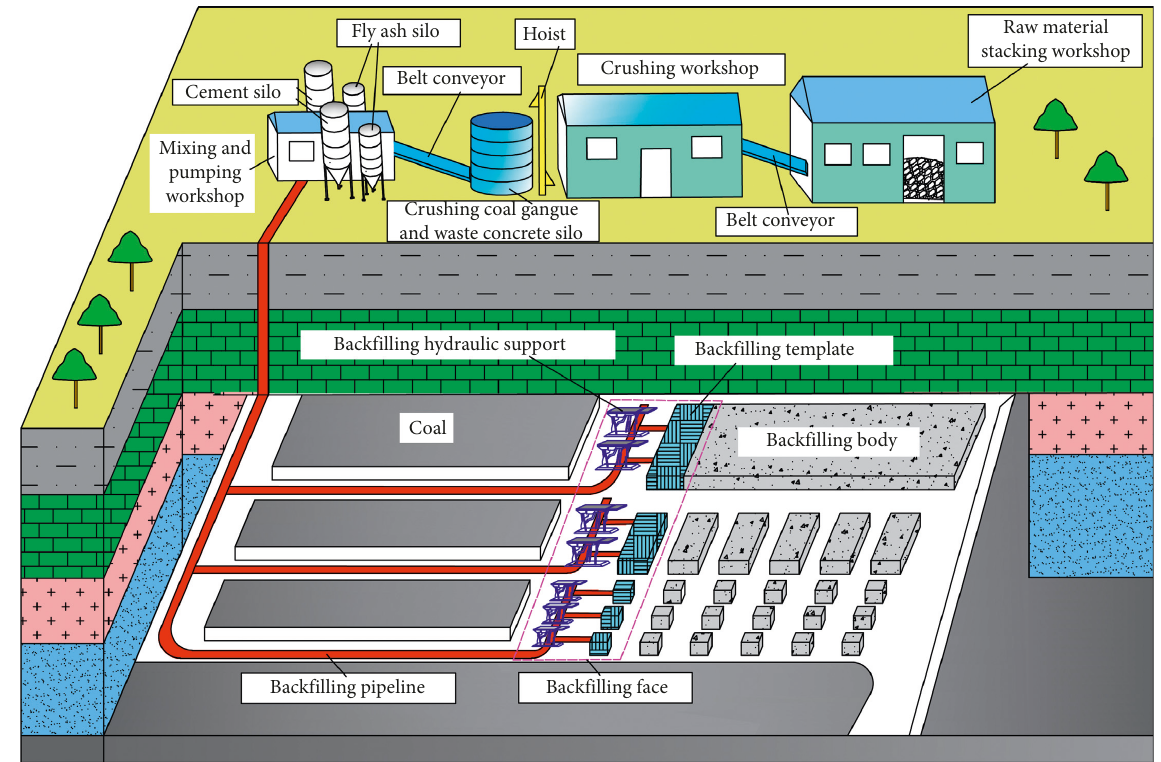
Figure 1: Schematic of cemented paste backfilling in a coal